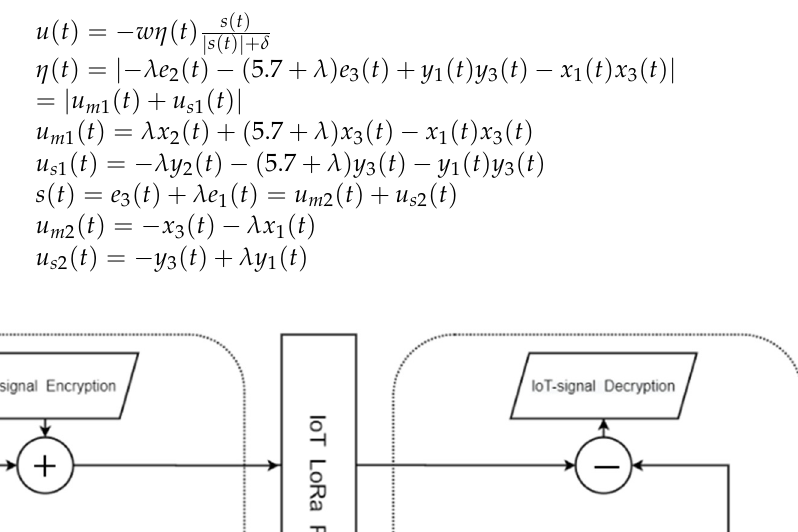
Figure 14. Temperature measured by DHT-22. 4.2. IoT Communication Channel In order to allow temperature sensing data to be transmitted in the IoT. We used the SX LoRa-1278 communication module, as shown in Figure 15. In terms of IoT communi- cation technology, one of the LoRa (Long Range) low-power wide-area network commu- nication technologies was an ultra-long-distance wireless transmission scheme based on spread spectrum technology, adopted and promoted by Semtech. LoRa uses a high spreading factor to obtain a higher signal gain. Compared with the general FSK, the sig- nal-to-noise ratio requires 8 dB, while LoRa only requires − 20 dB. This provides users with a simple system that can achieve long-distance, low power consumption, and large capac- ity, and can then expand the sensor network. Therefore, using the many advantages of LoRa, the nodes of each LoRa module were deployed in the space to collect the required data, such as temperature, humidity, distance, etc. However, because all LoRa frequency bands are publicly shared and free, we needed an encryption system to protect the secu- rity of these data.